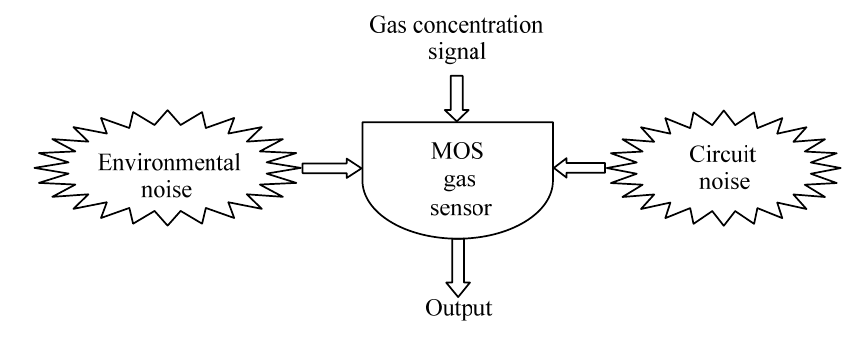
Figure 5. Block diagram of the inputs and outputs of an MOS gas